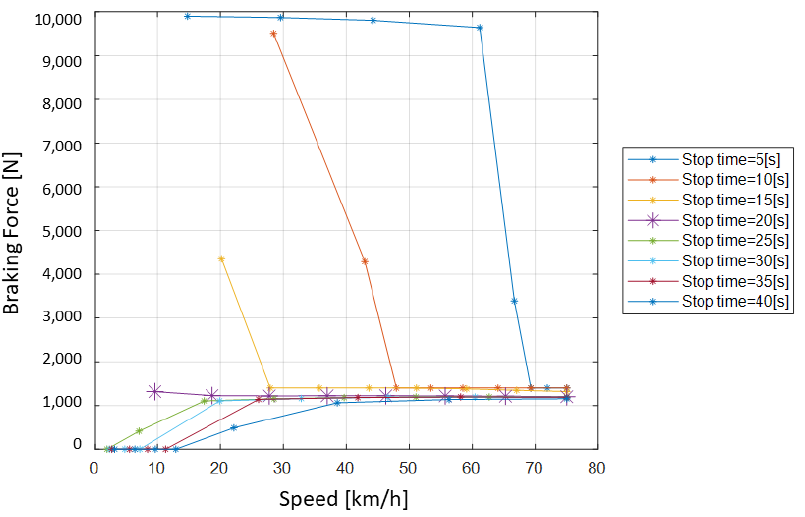
Figure 11. Braking forces vs speed at various stopping times, starting at 75 km/h. The highest energy recovery is obtained by stopping the car in 20 s (large purple star).